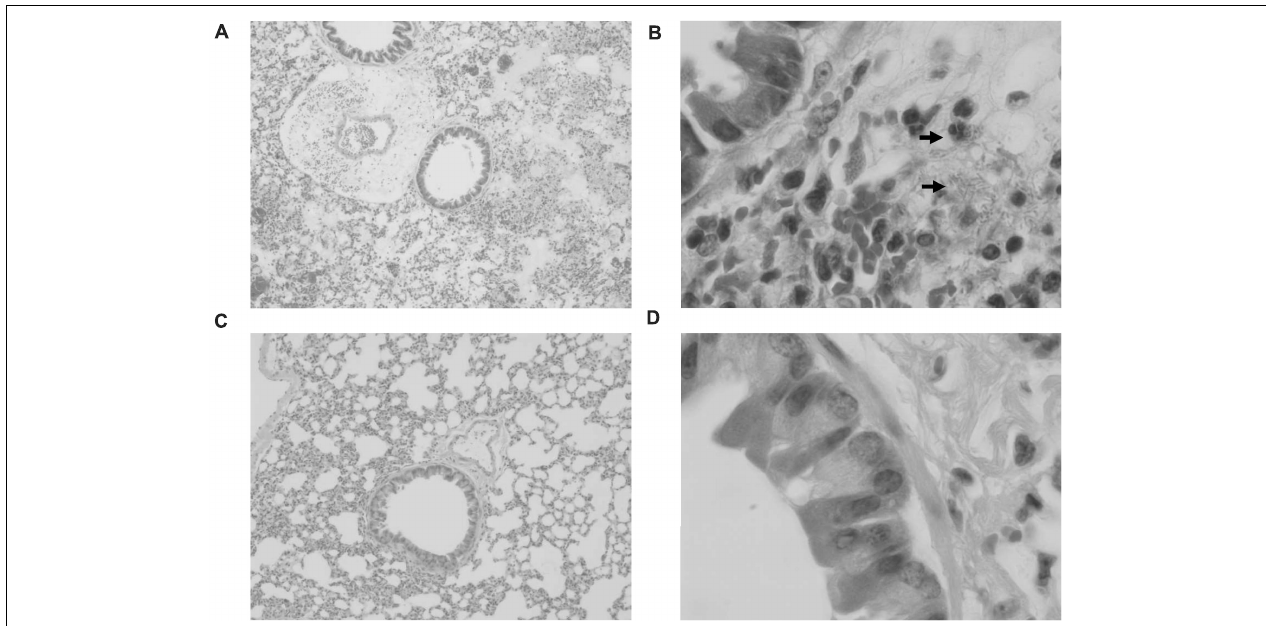
FIGURE 2 | Pathological micrograph of mouse lungs. In the control group ( n = 6), 50 × magnification (A) showed that the alveoli were filled with red blood cells and mucus, and a tendency of severe pulmonary bleeding was observed. At 1,000 × magnification (B) , there are a large number of bacteria in the lungs, and inflammatory cell infiltrations in the lung interstitium can be seen. In the treatment group ( n = 6), a small amount of red blood cells in the alveoli can be seen at 50 × magnification (C) . At 1,000 × magnification (D) , the infiltration of inflammatory cells can be seen whereas no bacteria can be found.